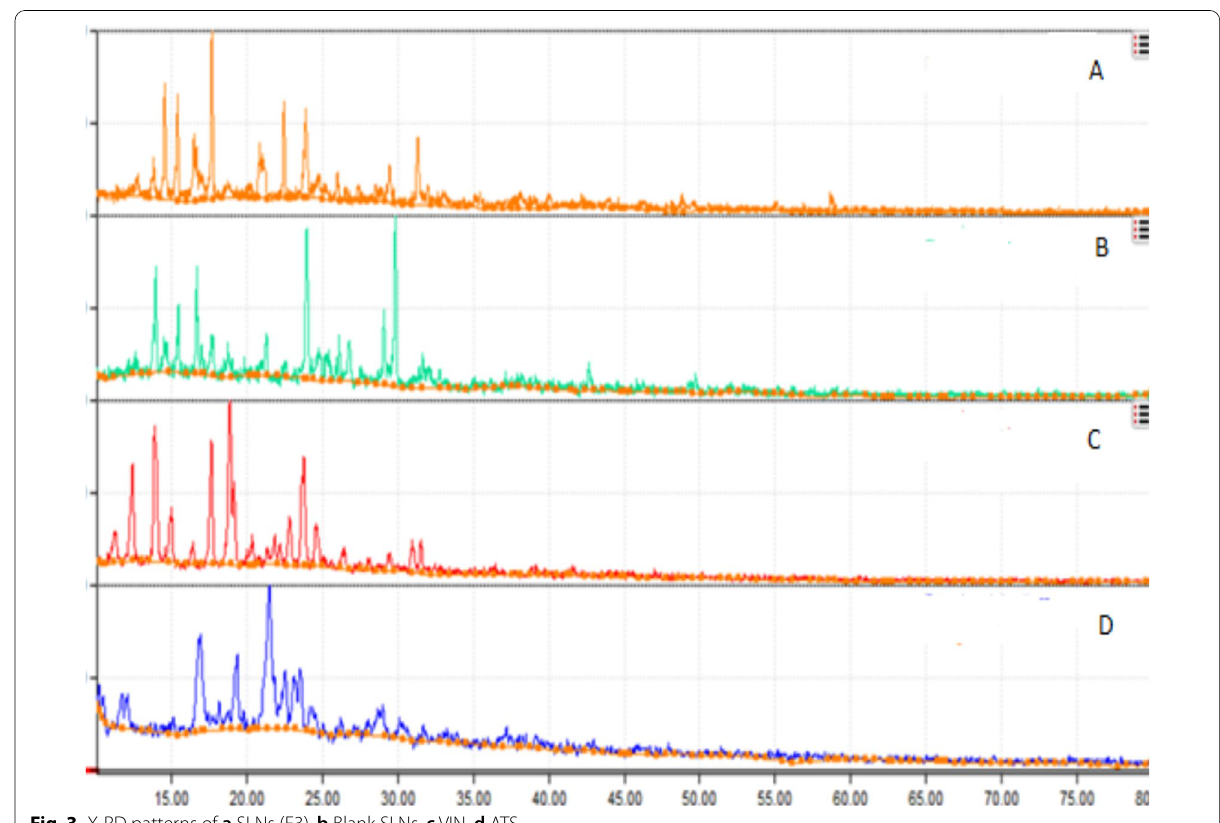
Fig. 3 X-RD patterns of a SLNs (F3), b Blank SLNs, c VIN, d